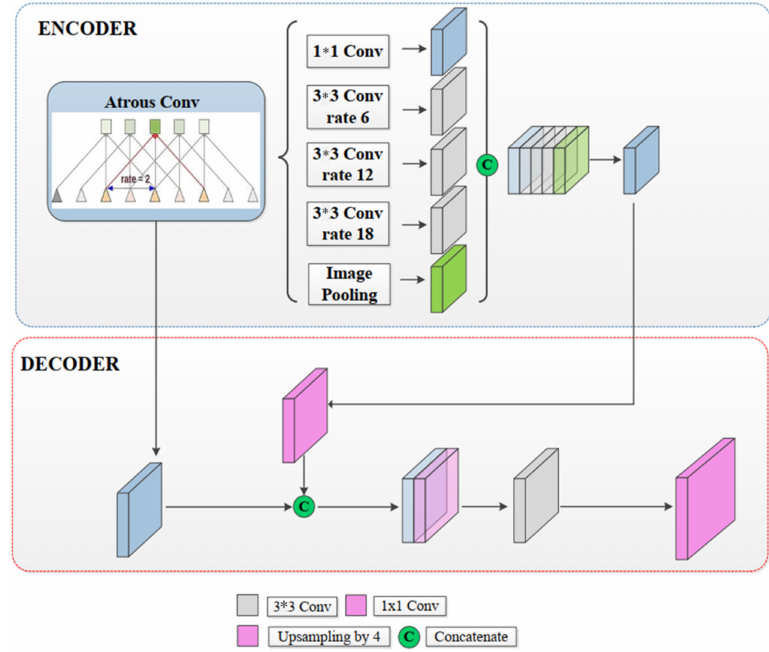
Figure 1. The basic architecture of the DeepLabv3+ neural